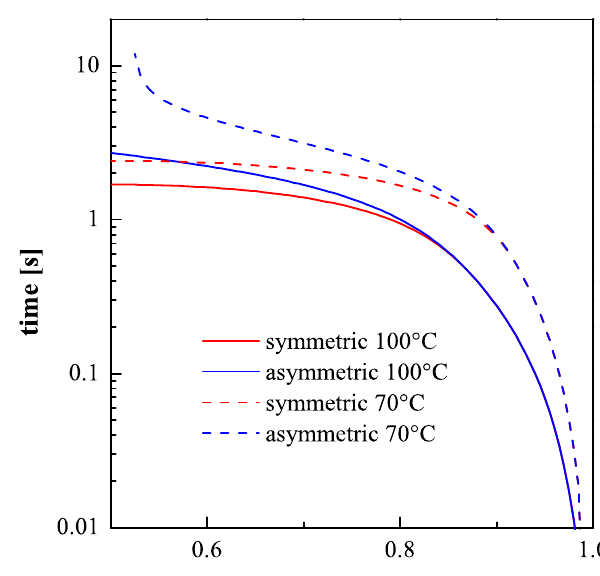
Figure 11. Distributions of the times taken to cool down to 100 °C and to 70 °C on the unheated side of the sample, calculated both for the T_off sample and for the asymmetrically heated sample.